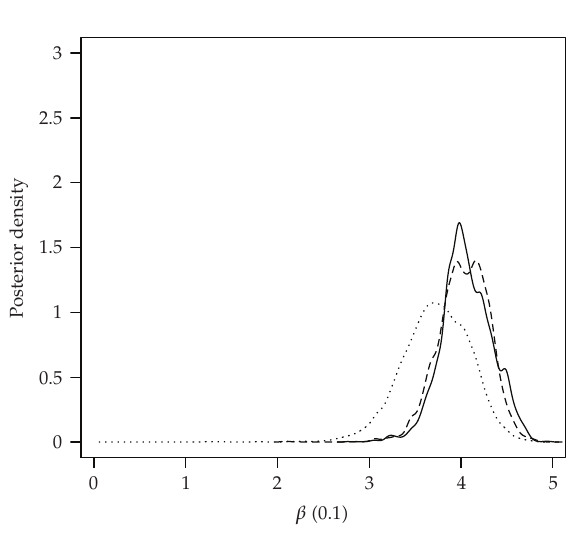
Figure 3: Plots of posterior densities for β 0 . 10 , where the dotted curve is for improper uniform prior, the dashed and solid curves are for power priors with parameters (cid:2) μ a (cid:2) 0 . 99 , 0 . 010 (cid:5) ,